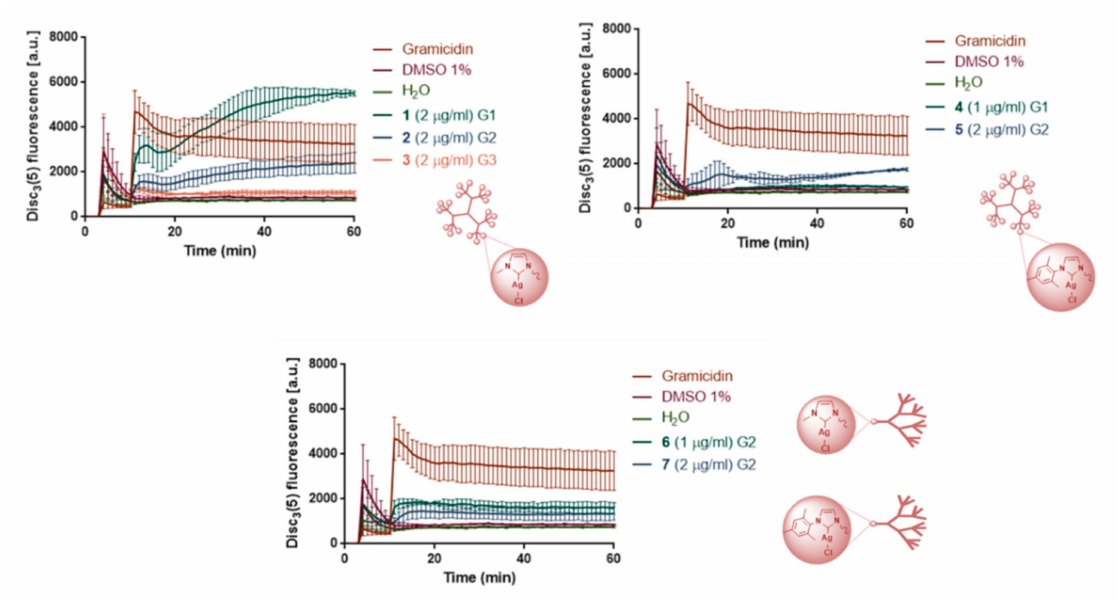
Figure 4. Disc 3 (5) fluorescence graphs cell membrane depolarization of B. subtilis WT168 in the presence of compounds 1–7 with the corresponding schematic representation of